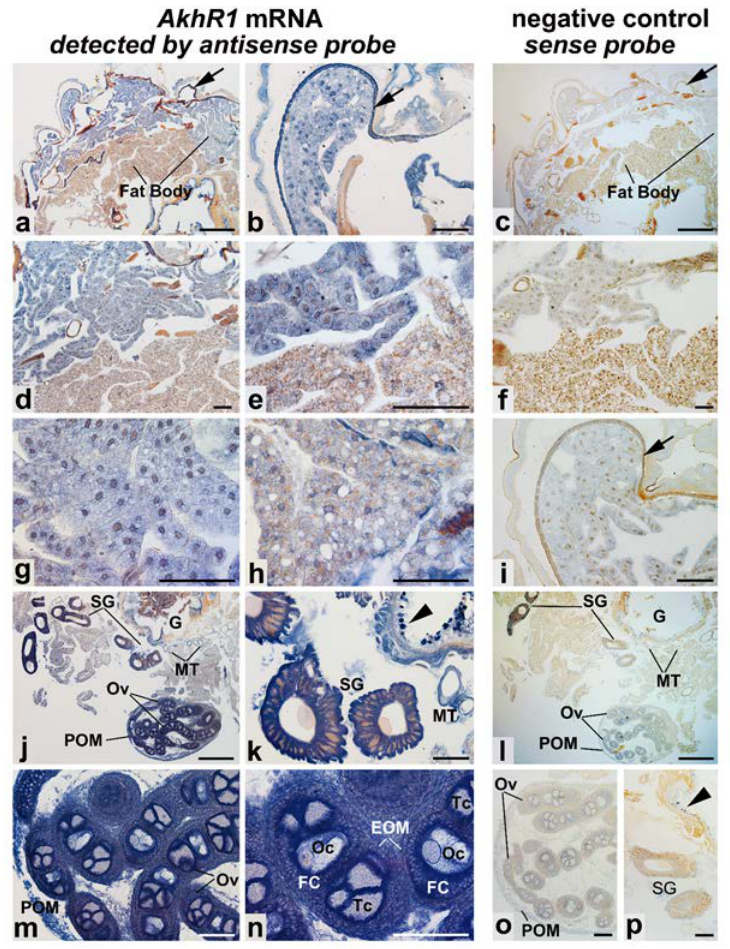
Figure 5. In situ expression of BmAKHR1 mRNA in Bombyx mori larval tissues. ( a ) AKHR1 mRNA expression in two di ff erent types of the fat body (peripheral and perivisceral fat body) and in the epidermis. ( b ) A detailed view of the epidermis and adjoining fat body. ( c ) The sense probe did not label any tissues in the parallel section to the one shown in A. ( d , e ) Di ff erent magnification images